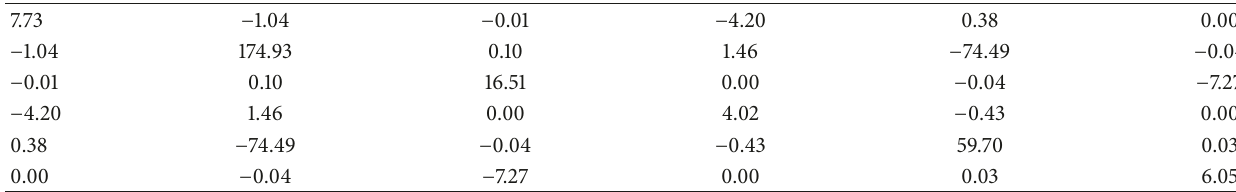
Table 8: Structure B stiffness matrix B ( ⋅ 10 5 )N/m.